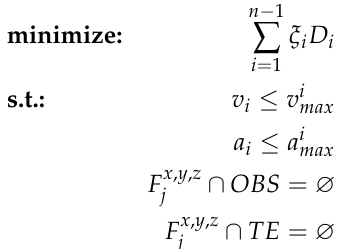
Figure 1 gives an example of a path segment within a whole path: